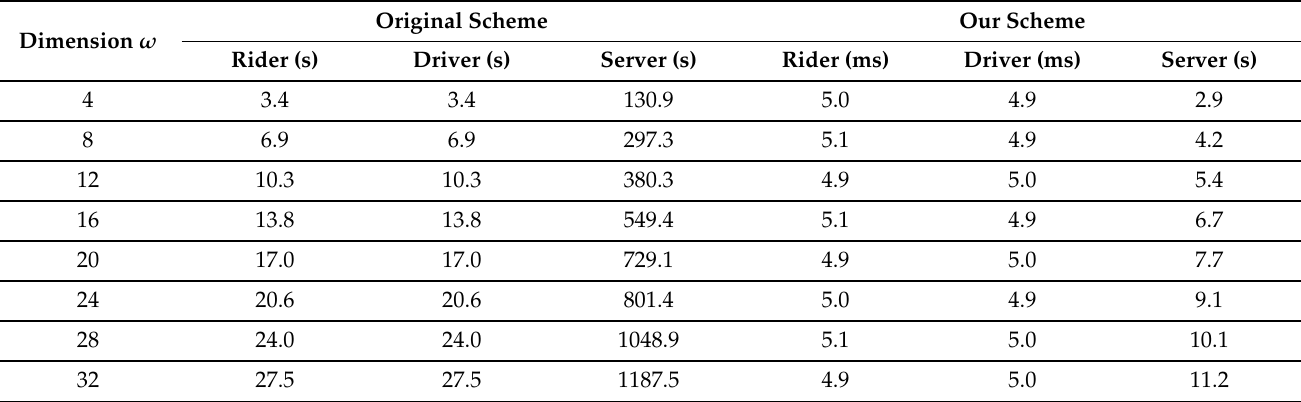
Table 4. Communication overhead and computation